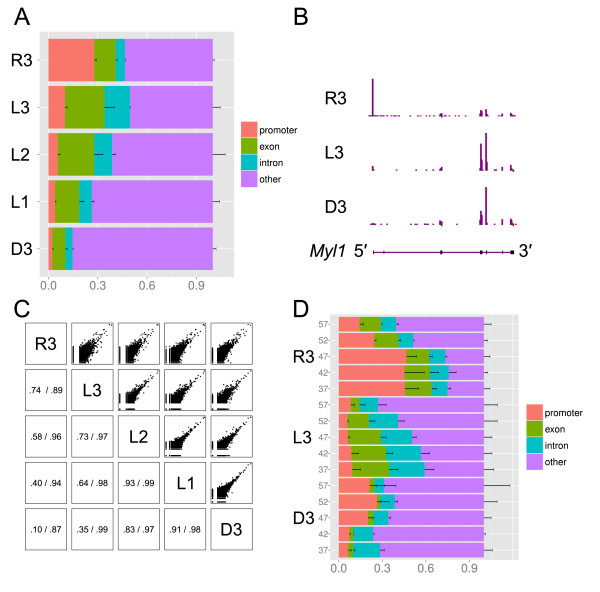
Genomic features and expression levels of DNA, LNA and RNA-based libraries. (A) Percentage of reads that align to known genomic features (promoter, intron, exon), for the libraries comparing the template-switching (TS) oligonucleotides R3, L3, L2, L1, and D3. Technical triplicates were averaged and error bars represent standard deviations. (B): Genomic representation of the R3, L3 and D3 libraries on the Myl1 locus (11 kbp). Aligned CAGE tags are represented as horizontal bars colored in purple for the sense strand and in green for the antisense strand, where the height is proportional to the number of tags in a given genomic bin, after normalizing tag counts per million (TPM) and averaging the triplicates. The highest peaks have the same size in the three tracks, representing 5717, 1665 and 180 TPM values for R3, L3 and D3 respectively. (C) Pairwise comparisons between the D3, L1, L2, L3 and R3 libraries. Each square provides data for the pair of libraries defined by the horizontal and vertical intersections with the diagonal. Upper part: Expression plots (logarithmic scale), where each dot represents the normalized number of reads aligning to a reference gene model (same strand only). Technical triplicates were averaged. Lower part: Pearson correlation coefficients before (left) and after (right) removal of strand-invasion artifacts. (D) Influence of temperature (indicated by grey labels) on TS with the R3, L3, and D3 TS oligonucleotides. Technical triplicates prepared on random-primed HeLa RNA.